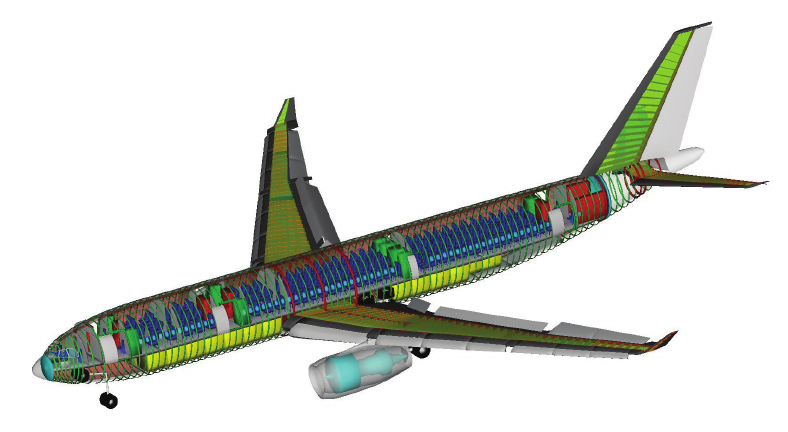
Figure 4. Geometry model of the reference aircraft [38].